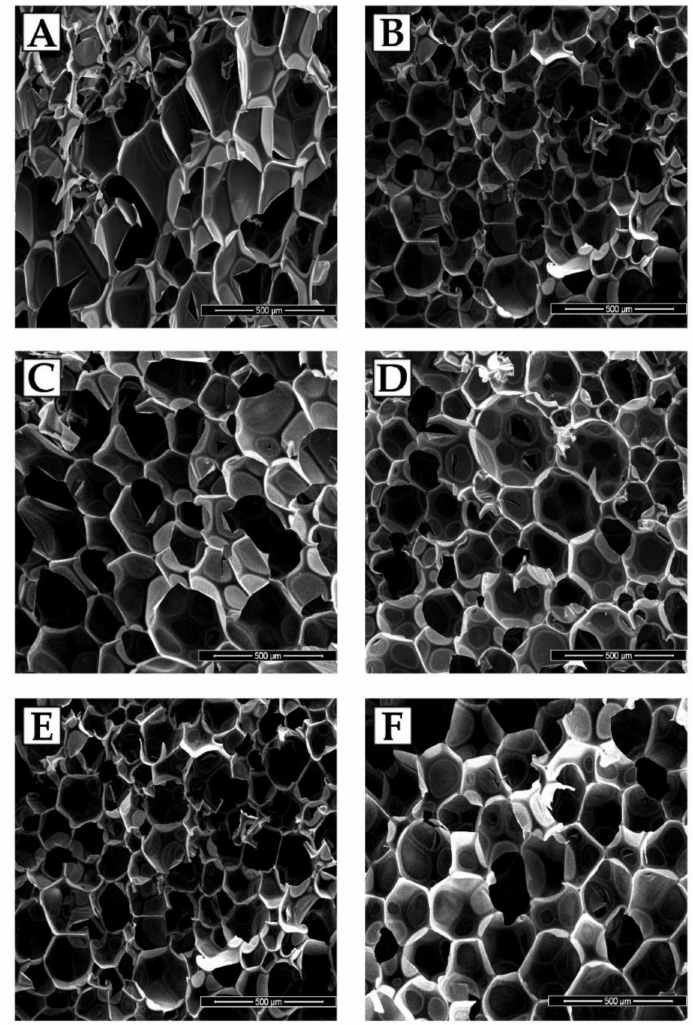
Figure 1. Cell structures of selected RPU/PIR foams: ( A ) EPC0, ( B ) EPC10, ( C ) EPC20, ( D ) EPC30, ( E ) EPC40, ( F )